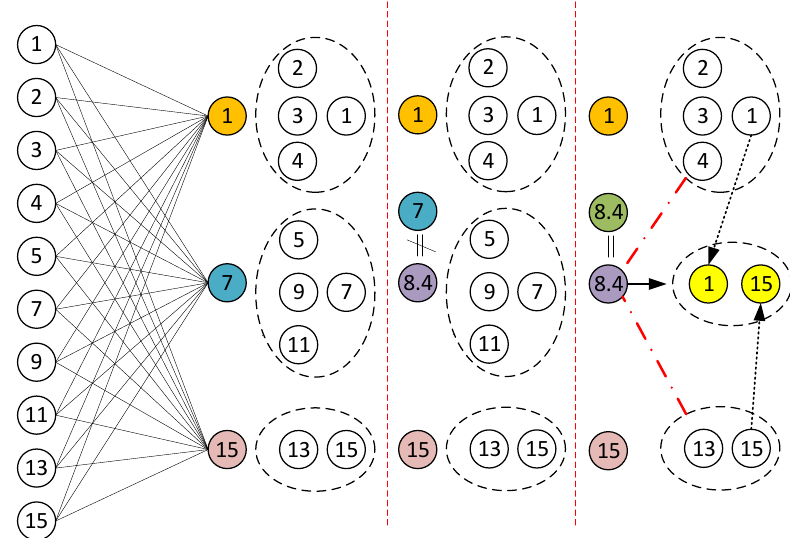
Figure 5. A case of cluster algorithm of the sensor node. Table 1. A case of calculation process of clustering algorithm of the sensor node. Degree of